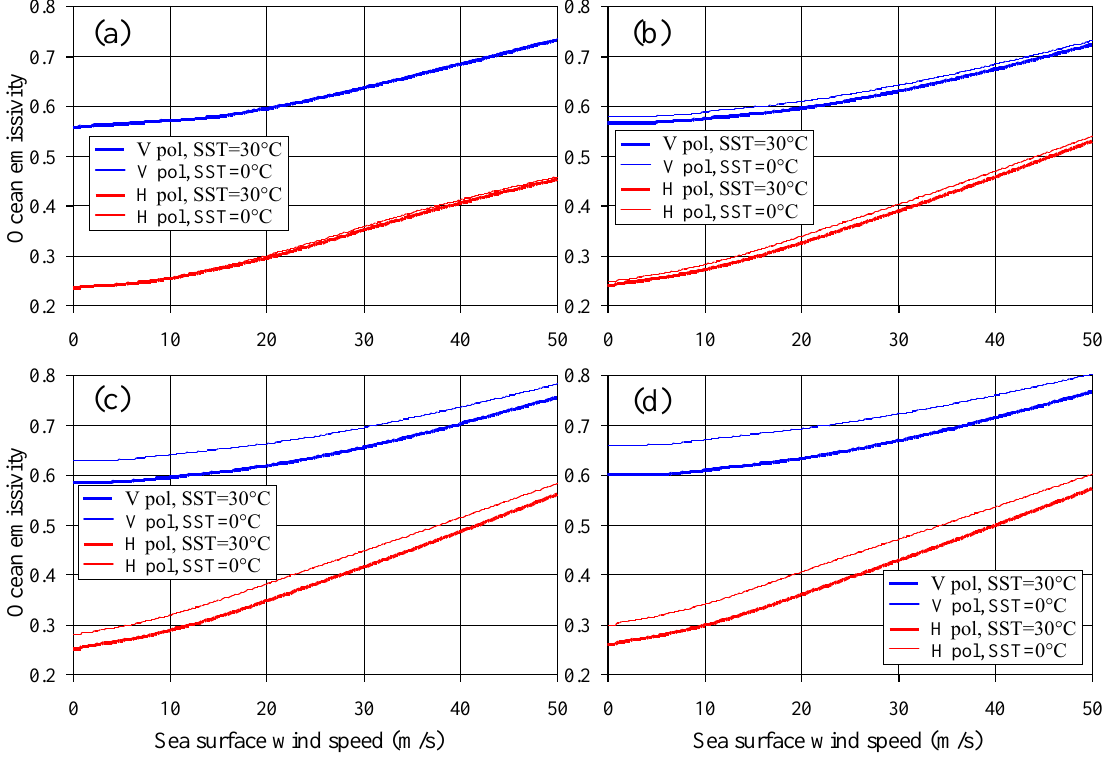
Figure 1. Ocean emissivity, calculated using Chapr12 model, as a function of sea surface wind speed WS for four lower AMSR-E frequencies: ( a ) 6.9 GHz, ( b ) 10.65 GHz, ( c ) 18.7 GHz, ( d ) 36.5 GHz. The thicker lines refer to SST = 30 °C, the thinner lines refer to SST = 0 °C. The upper (blue) curves are for vertical polarization, the lower (red) curves are for horizontal